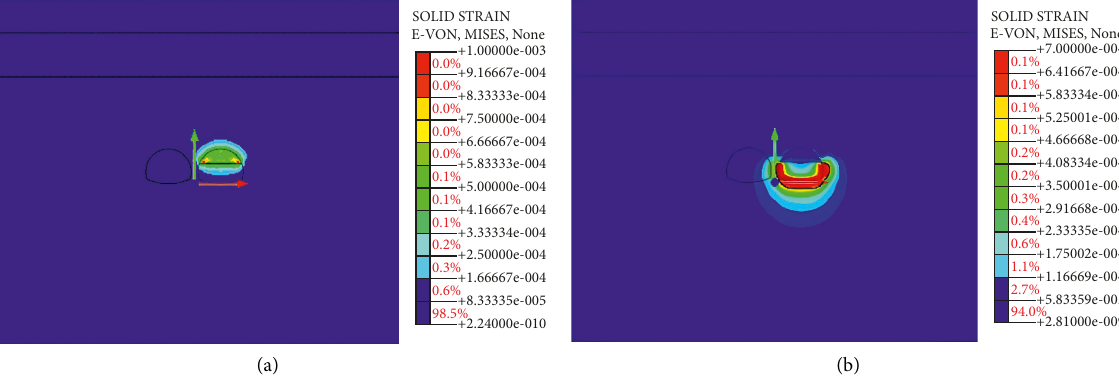
Figure 18: Plastic strain distribution (tunnel clear distance 0.5D). (a) Excavation of upper step and (b) excavation of lower step.